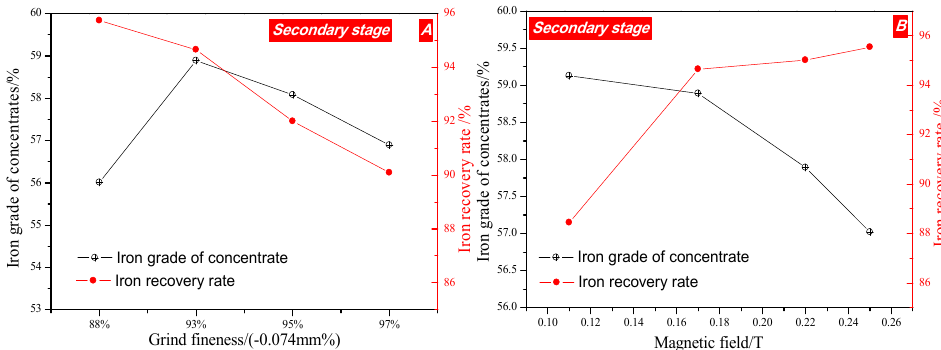
Figure 14. The results of secondary stage grinding-low intensity magnetic separation process: ( A )—Effect of secondary grinding fineness on iron recovery at 0.17 T magnetic field; ( B )—Effect of primary intensity of magnetic field on iron recovery under the condition of secondary grinding fineness of − 0.074 mm 93%, no dispersing agent.